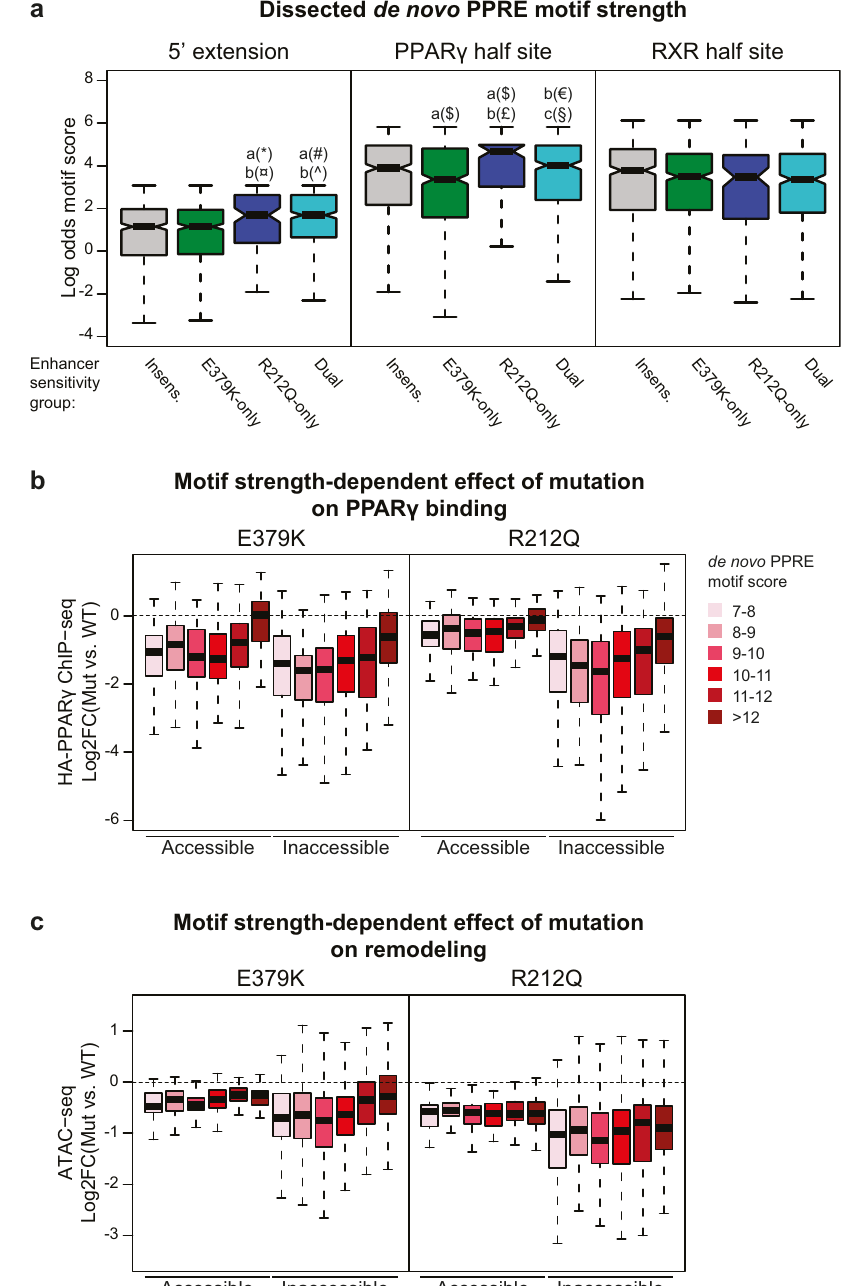
Fig.9|R212Q-sensitiveenhancersarecharacterizedbyastronger5 ’